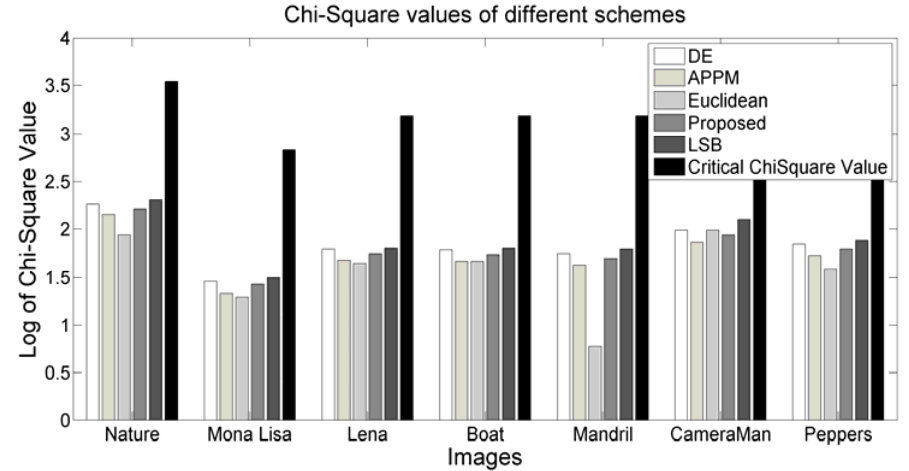
Figure 12. Comparison of chi ‐ square values among the schemes in the logarithmic scale.